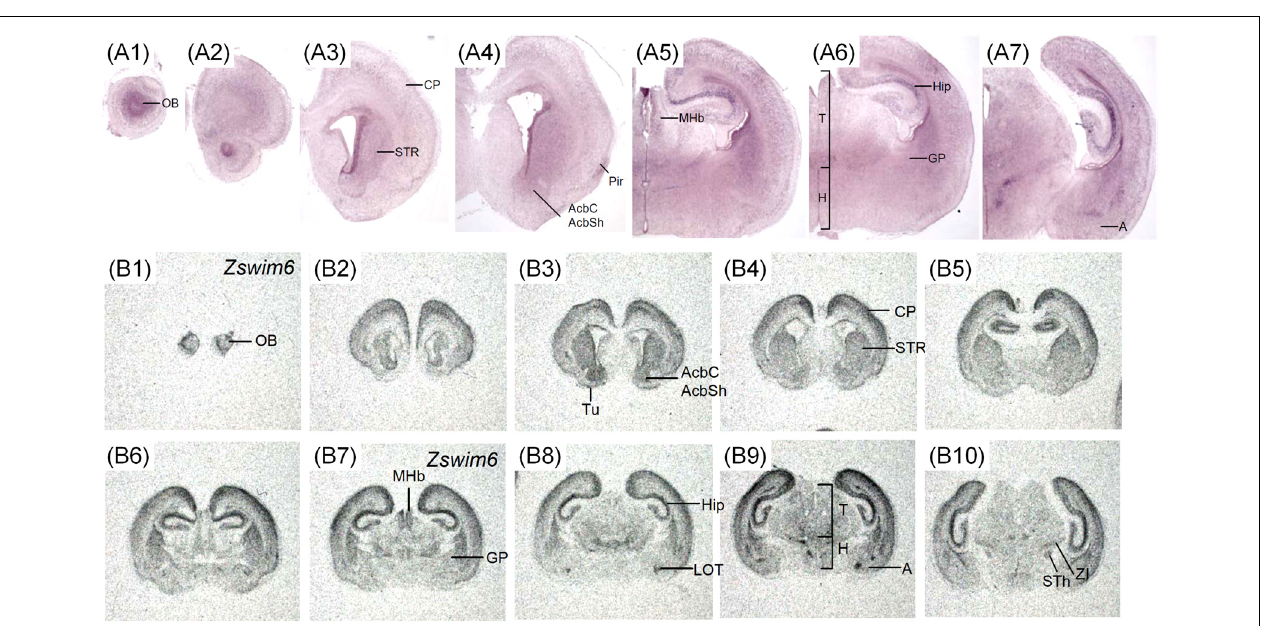
at the middle level of the striatum ( Figures 6A4,B4 , 7B ).